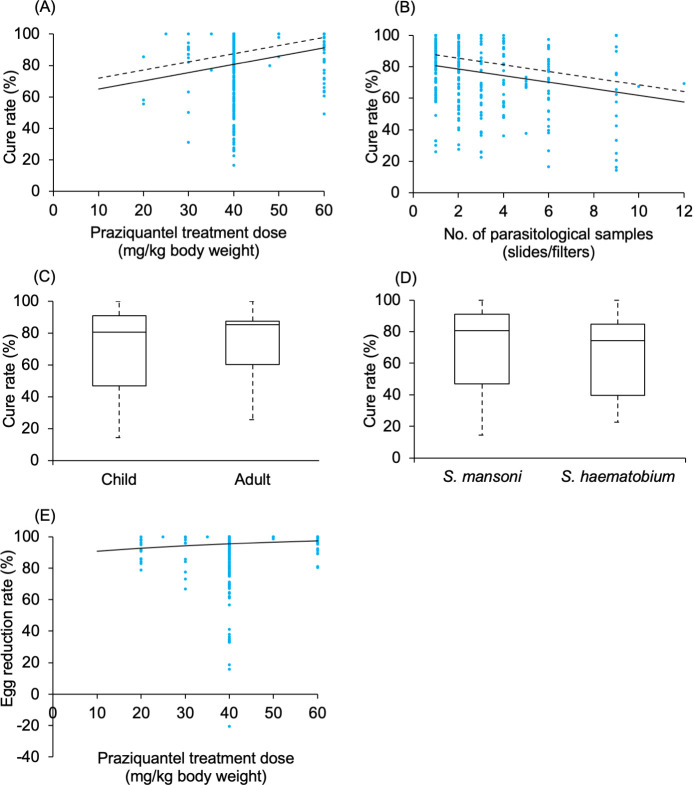
Fitted graphs for predictors identified from a random effects meta-regression model.Identified predictors’ effects on cure rate (graph A, B, C and D) and egg reduction rate (graph E): (A) praziquantel treatment dose over the range 10–60 mg/kg body weight on cure rate (B) the number of parasitological samples used for a diagnosis over the range 1–12 samples on cure rate (C) age category child (0 to 19 years old) and adults (20 years old or older) (D) parasite species S. mansoni and S. haematobium (E) praziquantel treatment dose over the range 10–60 mg/kg body weight on egg reduction rate. Scatter plot graphs A, B, and E: Data points indicate reported cure rate/egg reduction rate for each observation. Negative fraction indicates that praziquantel treatment was associated with increase of schistosome infection intensity. Lines are fitted graphs generated from random effects meta-regression. Scatter plot graph A and B: Dashed lines denote the highest level of cure rate over range that could be achieved among adults with S. mansoni infection treated with 60 mg/kg body weight praziquantel (for graph B) and one parasitological sample used for a diagnostic (for graph A). Heavy lines denote the cure rate over the reported dose/number of samples using mode of other predictors, i.e., children infected with S. mansoni and treated with 40 mg/kg body weight praziquantel treatment dose, diagnosed by one parasitological sample. Box plot C and D: Boxes denote range of possible maximum and minimum cure rate (%) estimated by models with heavy lines denoting model estimated cure rate using mode of predictors. Dashed lines denote the range of raw reported cure rate by each observation.